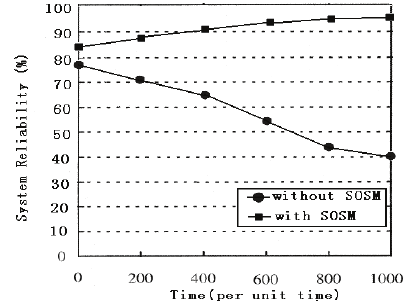
Fig. 6. Comparison of reliability of the service selection system between with SOSM and without